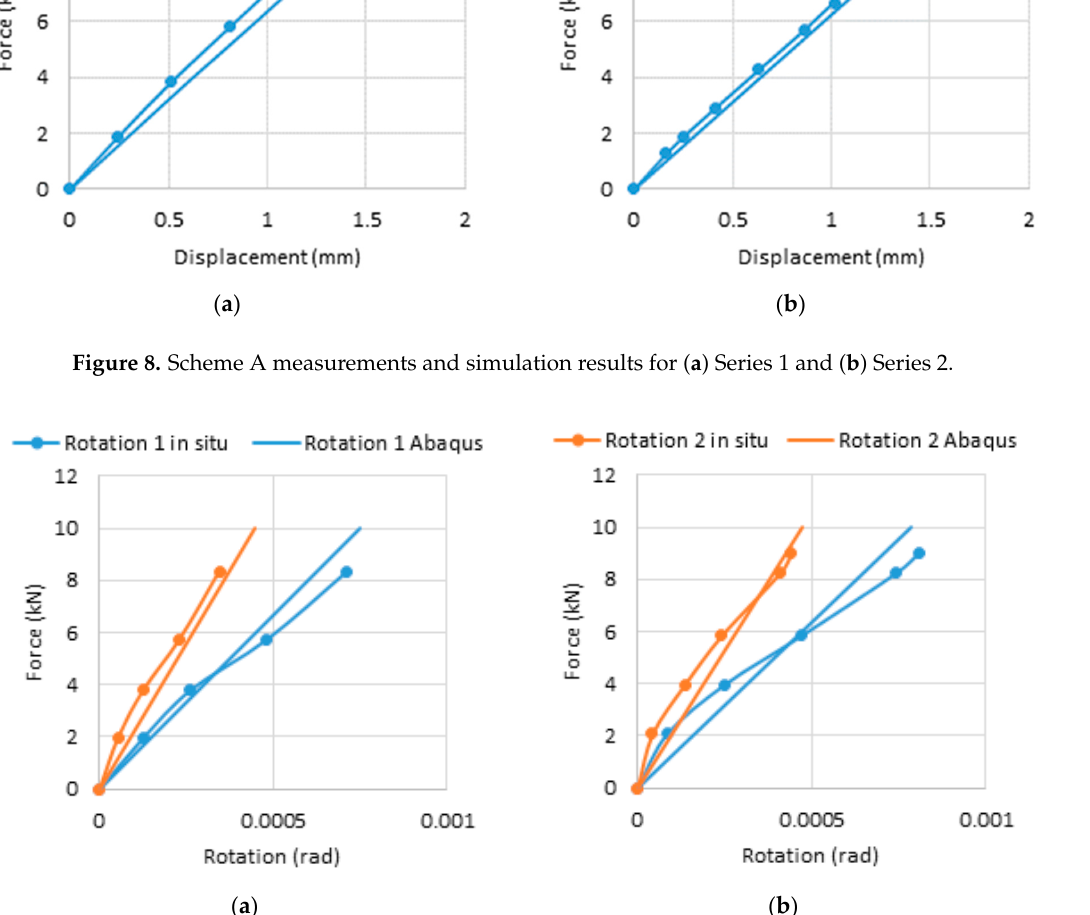
Figure 9. Scheme B measurement and simulation results for ( a ) Series 1 and ( b ) Series 2. Rotation 1—measurement using inclinometer B1; Rotation 2—measurement using inclinometer B2.